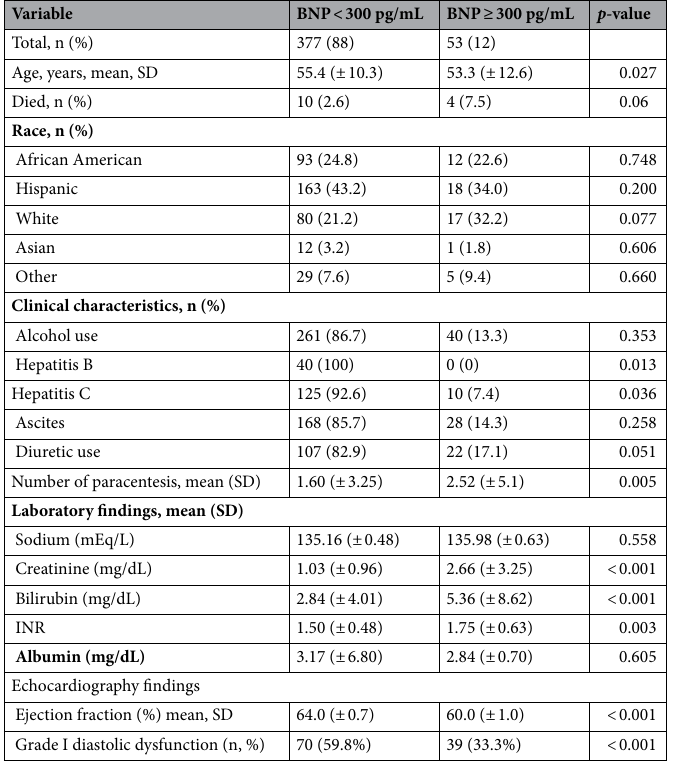
Table 1. General characteristics of patients according to BNP values. BNP brain natriuretic peptide, INR International Normalized Ratio, SD standard deviation.